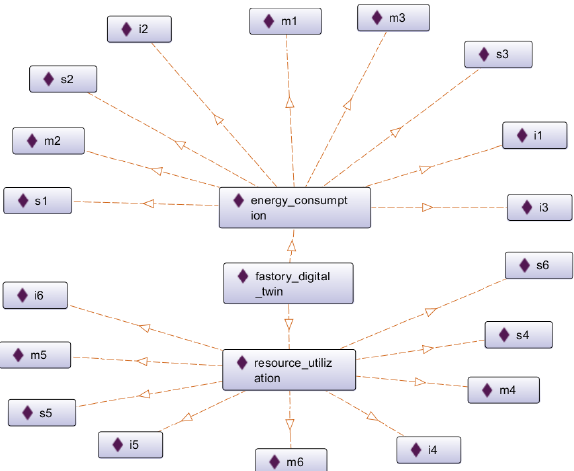
Figure 13. Twinning specifications for FASTory use case. [Source: Own figure which is a snapshot from Protege Ontology Editor].